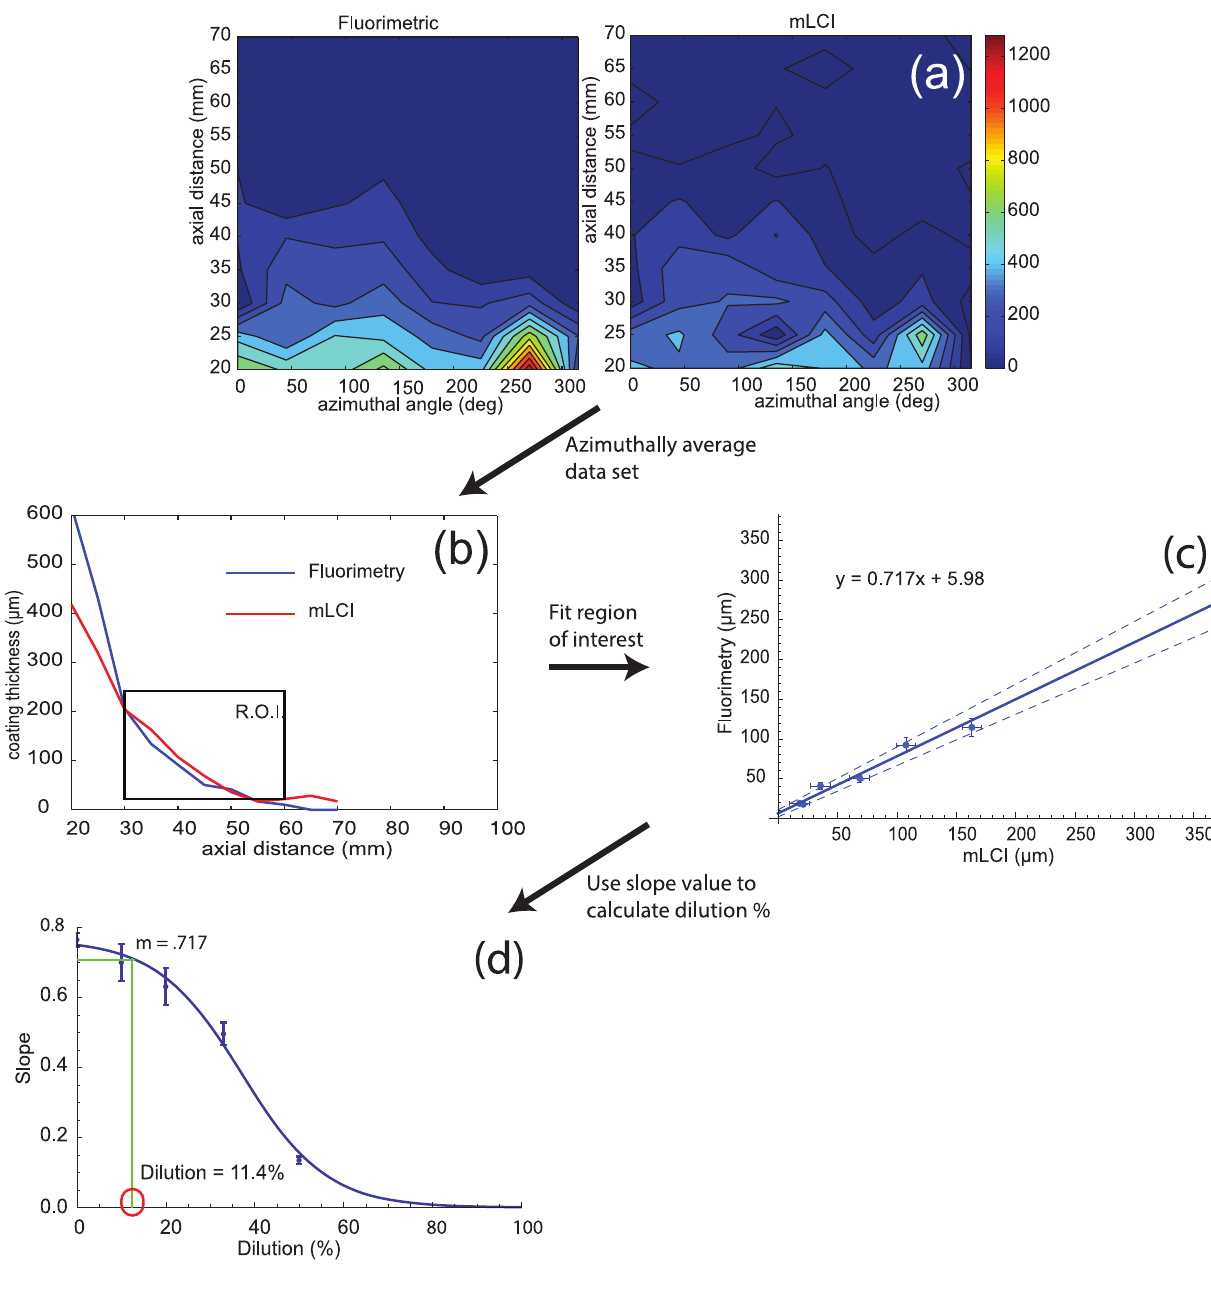
Figure 4. Example invivo microbicide gel dilution calculation to demonstrate the complete method. Part (a) displays a topological plot of data obtained by the dual-modality optical imaging instrument. These data are azimuthally averaged as shown in (b) and a region of interest is selected. The dataset is then plotted in (c) and a weighted least-squares fit is performed on the values in the ROI to find the slope value of the regression. This slope value is then used with the calibration curve (Fig. 3) to find a dilution value of 11.4 6 10.5%. The topological data in (a) and (b) were originally presented in Drake et al. [3,13]